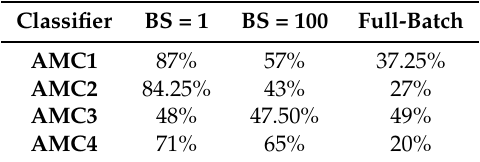
Table 6. AMC results based on MLP at different HLN and BS.